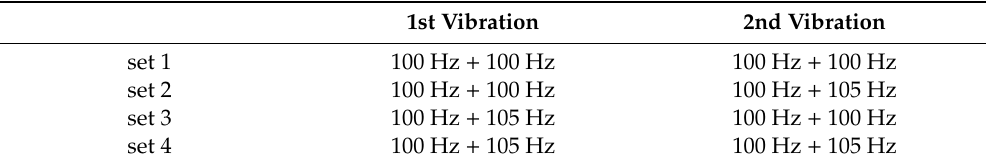
Table 3. Patterns of the second experiment.